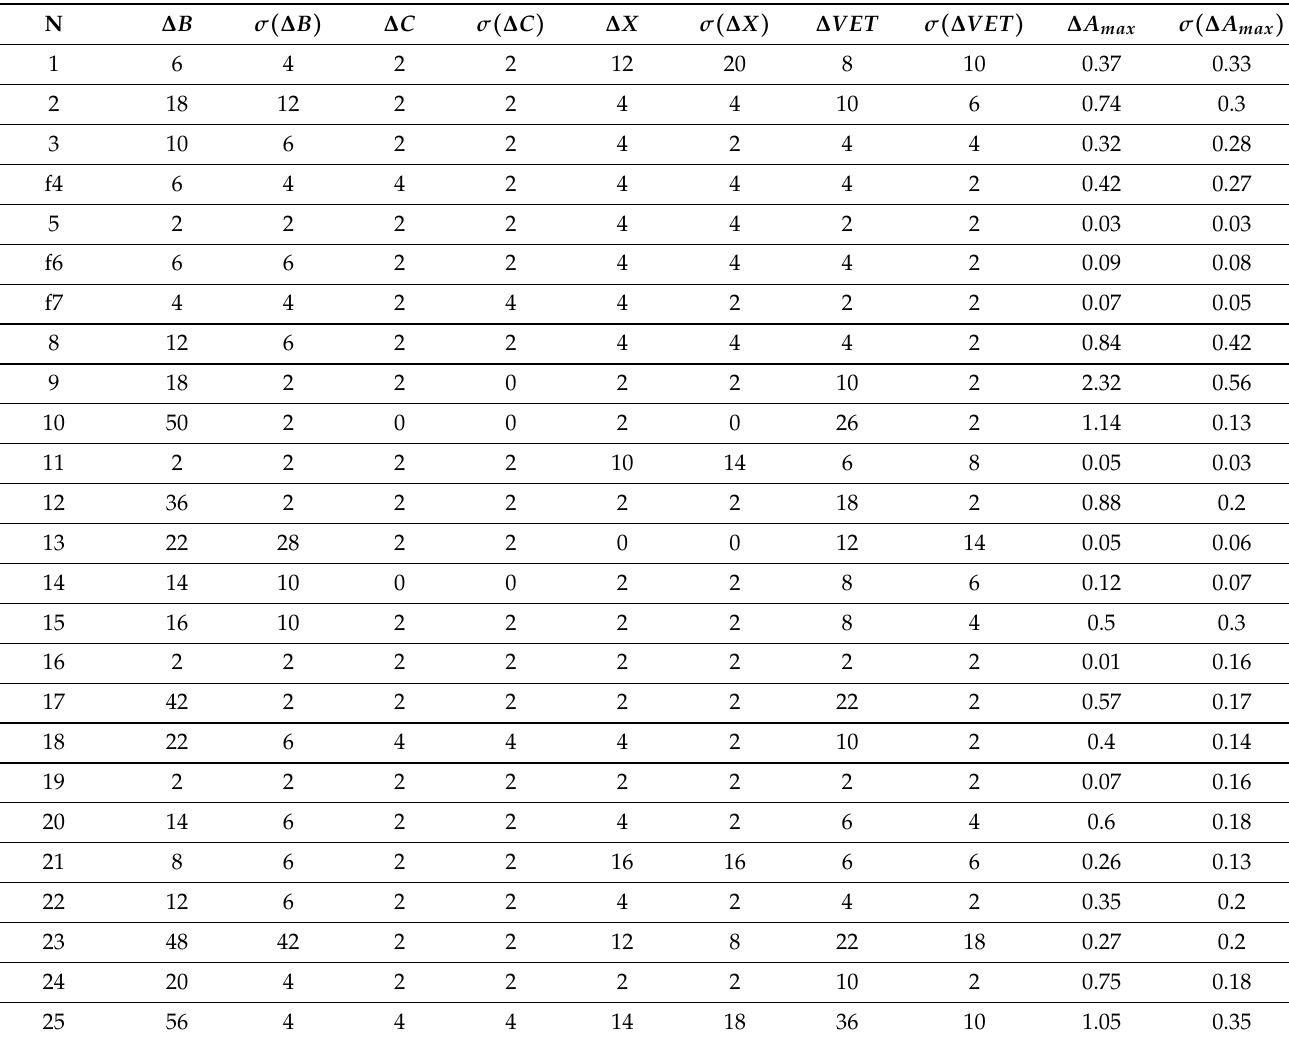
Table 2. The effectiveness of the proposed algorithm in identification of the characteristic B, C, and X points in the impedance cardiogram. ∆ B , ∆ C , ∆ X denote the mean absolute values of the differences in the positions of B, C, and X points and their corresponding standard deviations σ B , σ C and σ X (both expressed in ms ) between values obtained from the algorithm and indicated by an expert. The analogous quantities ∆ VET , σ ( ∆ VET ) were also presented for VET (ventricular (cid:16) (cid:17) dZ ejection time) and A max = expressed in Ω / s (the amplitude of the systolic wave on the dt max impedance